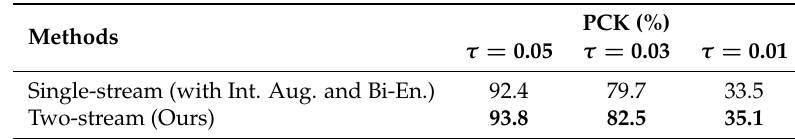
Table 3. Comparison of single-stream and two-stream architecture. We analyzed the effectiveness of the two-stream based regularization with ResNet-101